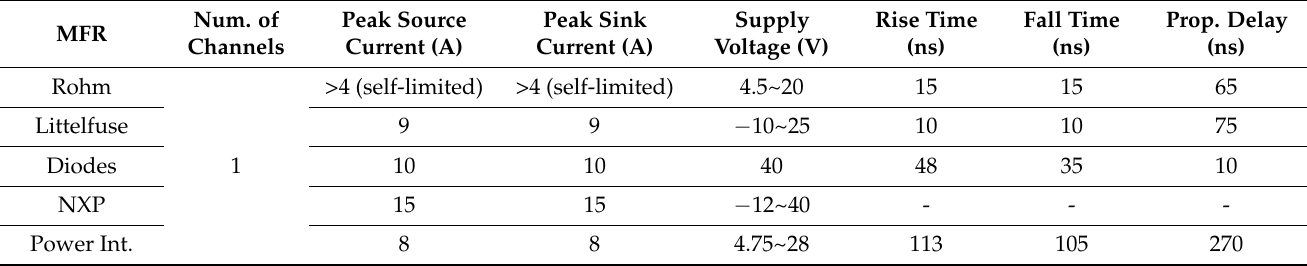
Table 37. Commercial SiC MOSFET drivers by Rohm Semiconductor, Littelfuse, Diodes Incorporated, NXP Semiconductors, and Power